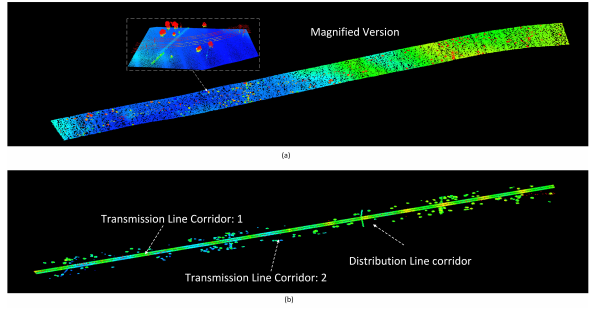
Figure 5. (a) Dataset with ground points, (b) Dataset without ground points.